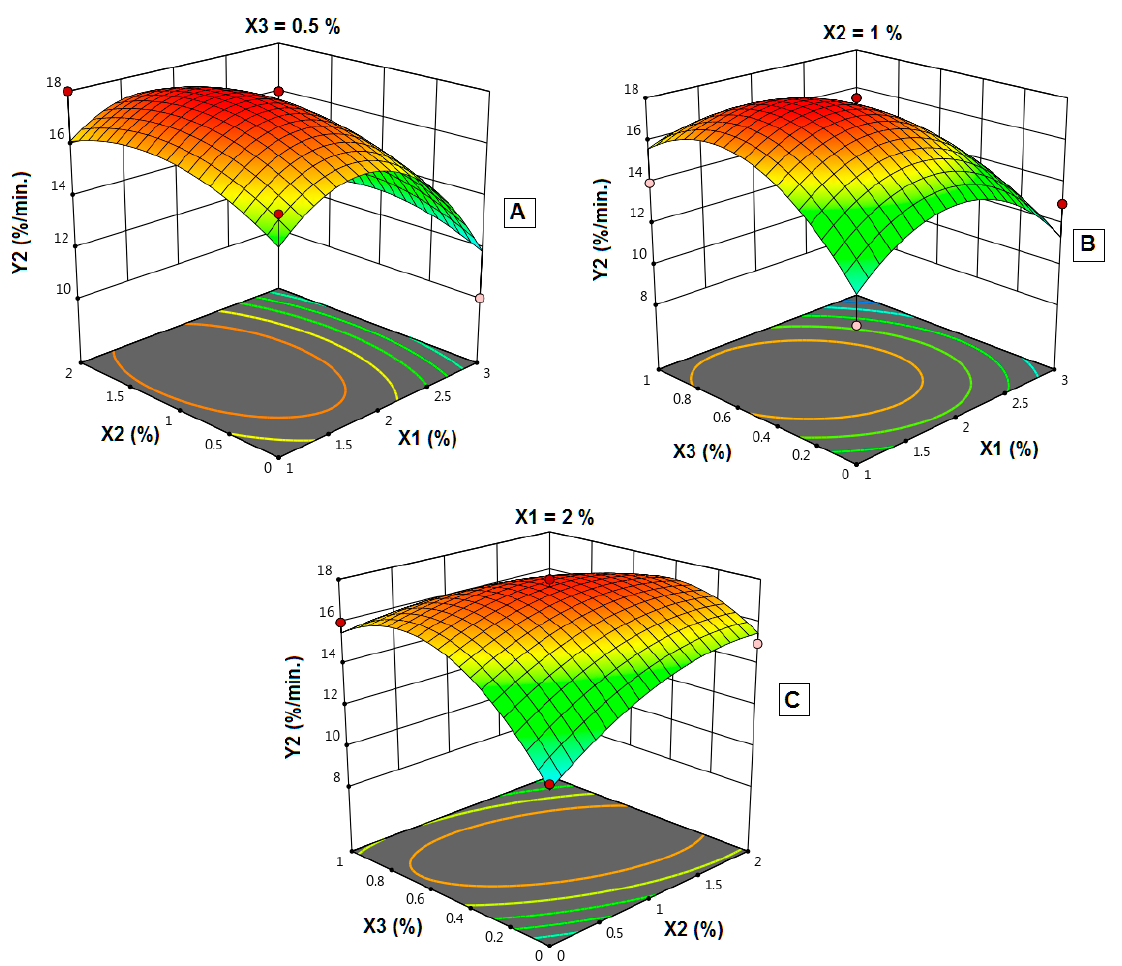
Figure 11. Influence of independent variables on the in-vitro initial dissolution rate (Y 2 ). ( A ) Effect of polymer concentration (X 1 ) and plasticizer concentration (X 2 ) on Y 2 at 0.5% X 3 . ( B ) Effect of polymer concentration (X 1 ) and disintegrant concentration (X 3 ) on Y 2 at 1% X 2 . ( C ) Effect of plasticizer concentration (X 2 ) and disintegrant concentration (X 3 ) on Y 2 at 2% X 1 .